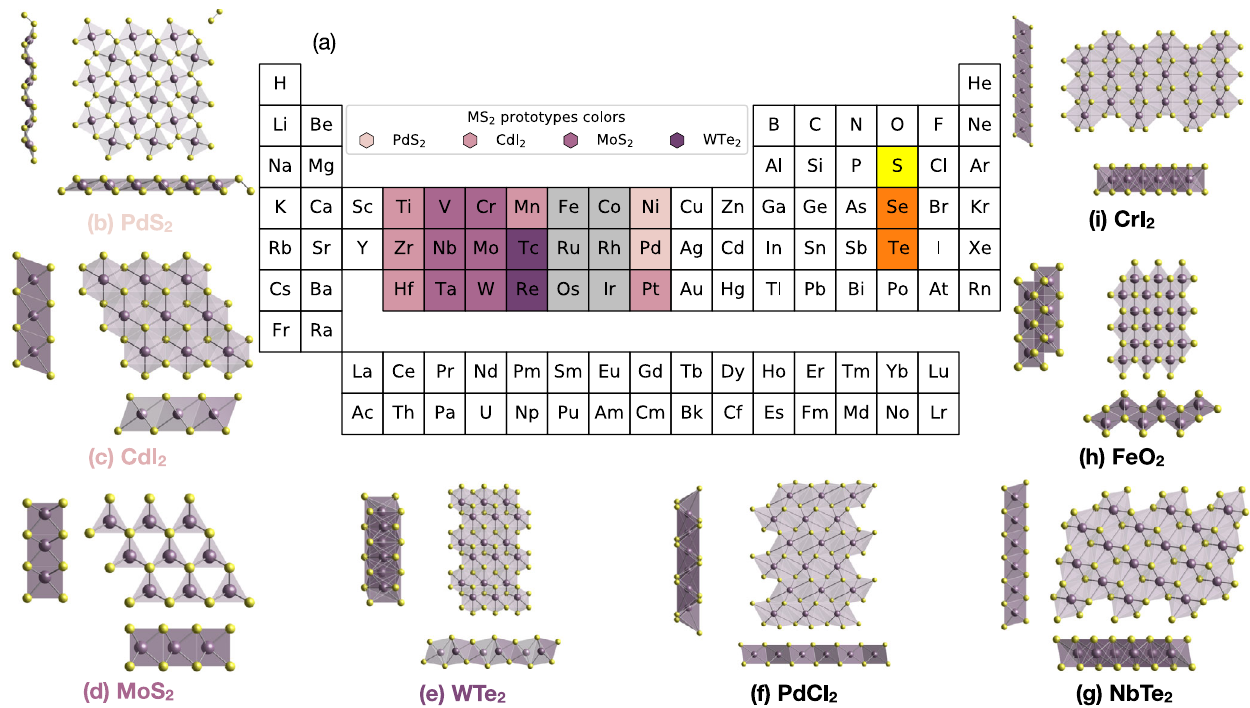
Fig. 1 Chemical and coordination space. a Periodic table showing the elements selected. TM boxes are coloured according to the MX 2 2D GS prototype, as reported in Fig. 2. Grey boxes indicate non-layered, 3D ground-state TMDs. Sulfur is highlighted in yellow while the other calchogenides are in orange. b – i The sides and top views of the eight MX 2 prototypes. The space group of each prototype is reported in Supplementary Table